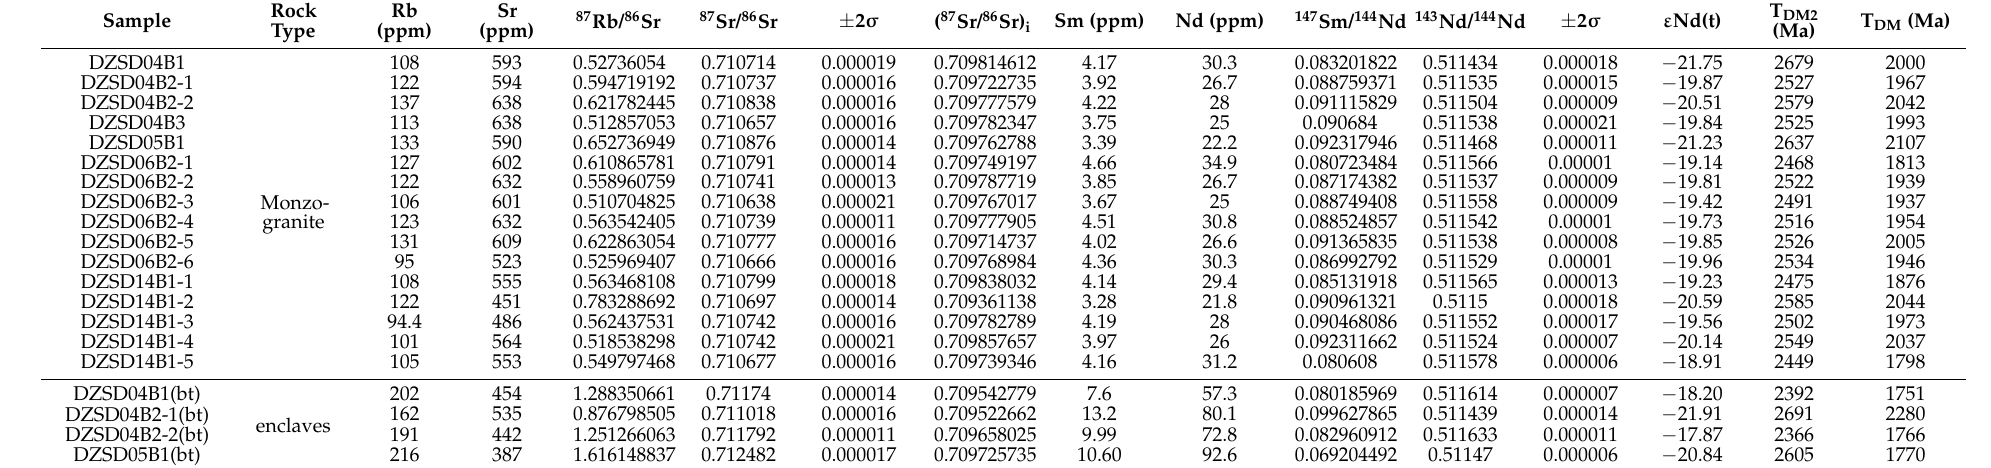
Table 2. Rb-Sr and Sm-Nd isotopic results of host granitoids and dark enclaves from the Dazeshan